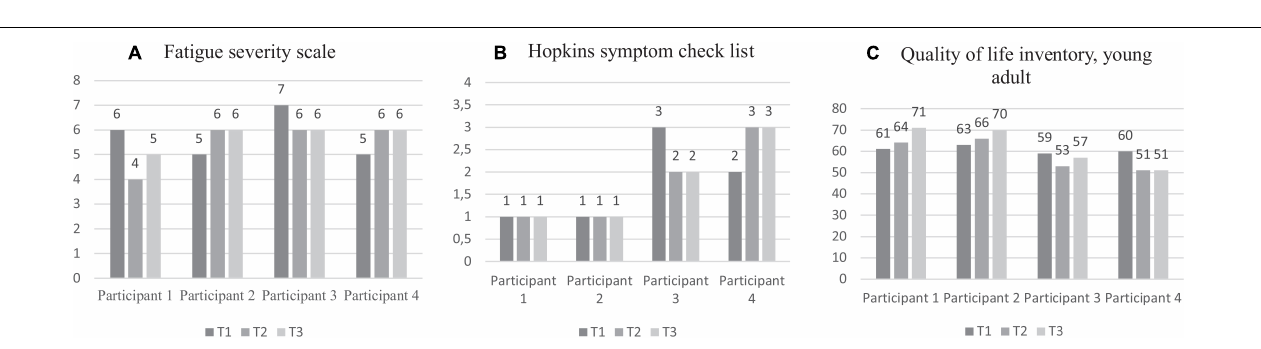
FIGURE 1 | Individual scores from the hotel task at preintervention, postintervention, and 6-month follow-up. (A) Raw scores of “deviations from optimal time allocation” are presented in seconds. Higher scores indicate worse performance. (B) Number of tasks attempted are reported in raw scores. Higher scores indicate better performance.